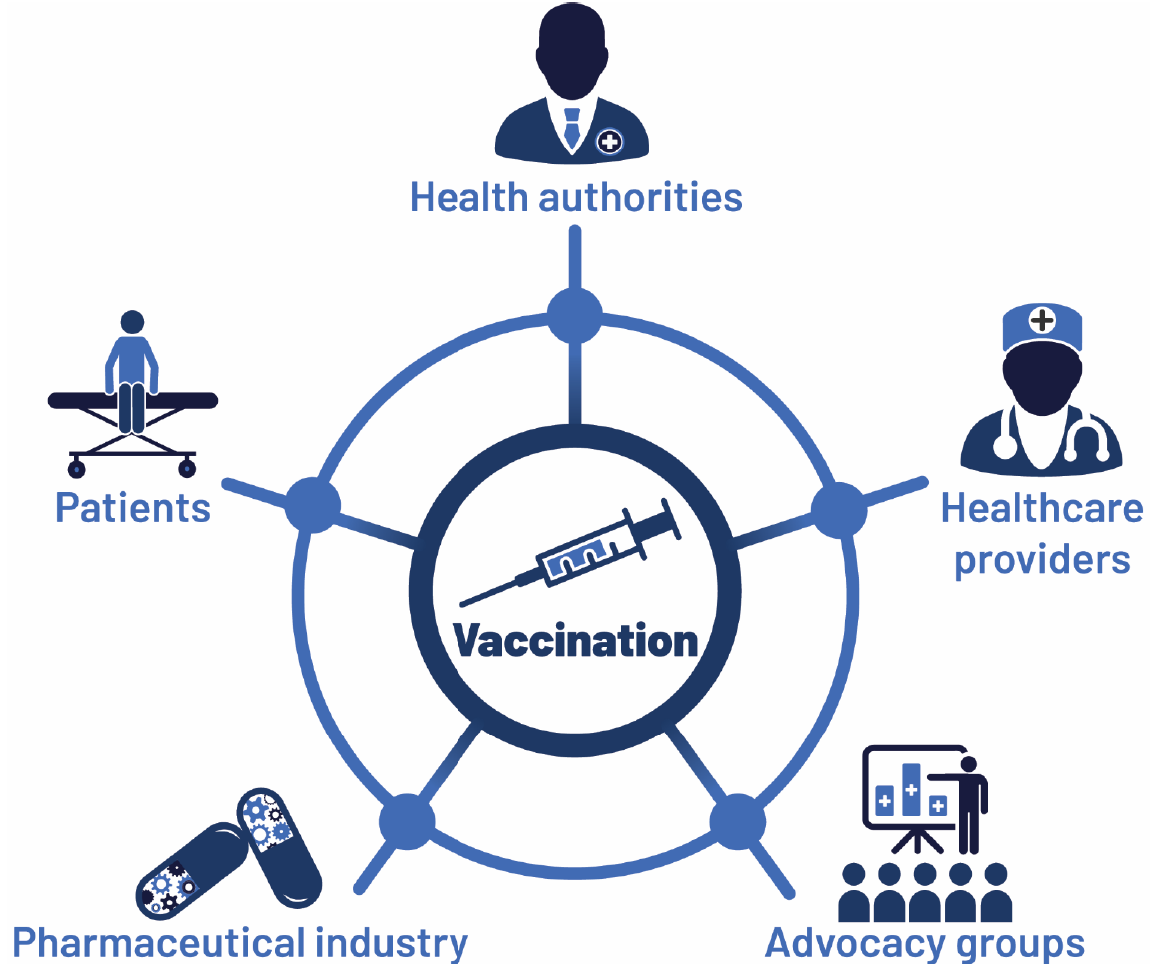
Figure 1. Network of stakeholders involved in the process of vaccination.